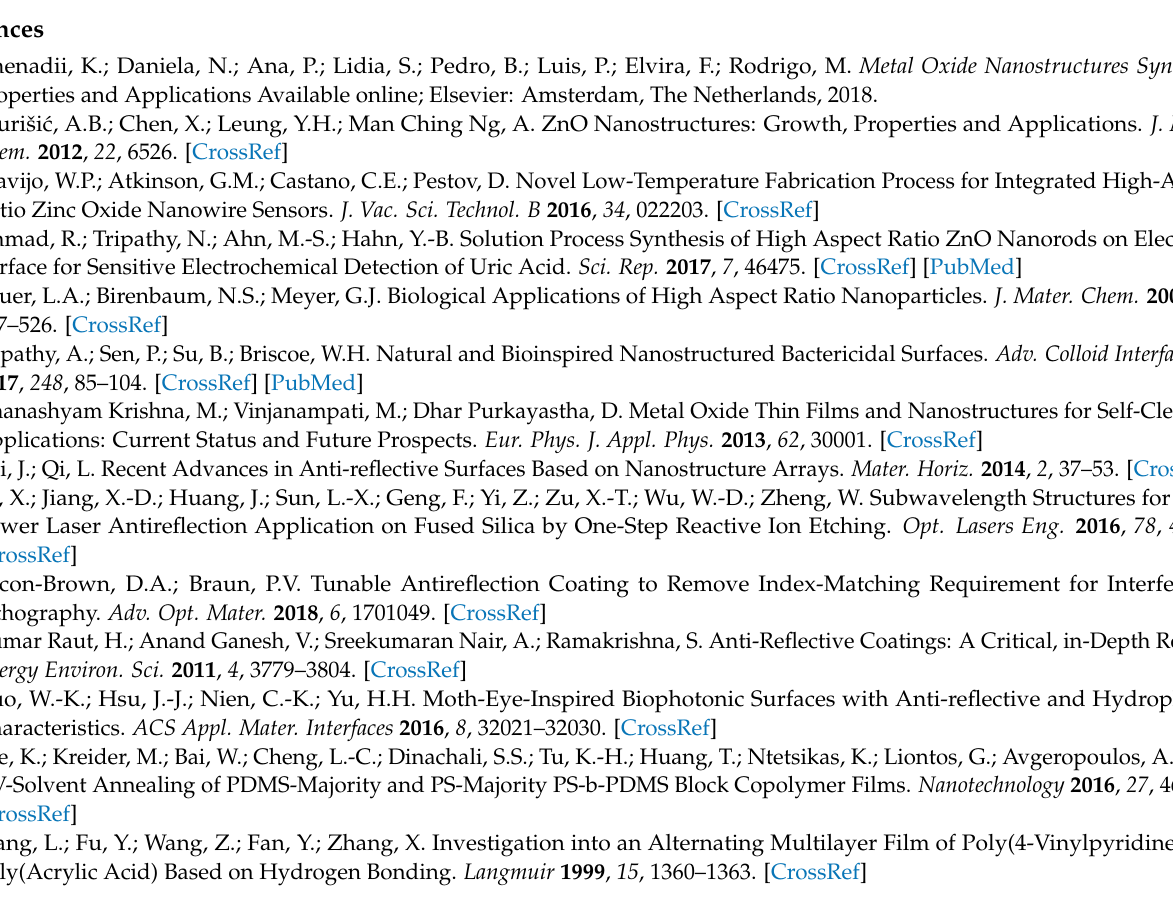
tetrahydrofuran; Figure S5: SEM image of SiO 2 nanorods array fabricated by different RIE chemistry: anisotropic etching of SiO2 by CHF 3 (a) 5 min, (b) 10 min; isotropic etching of SiO 2 by CF 4 + O